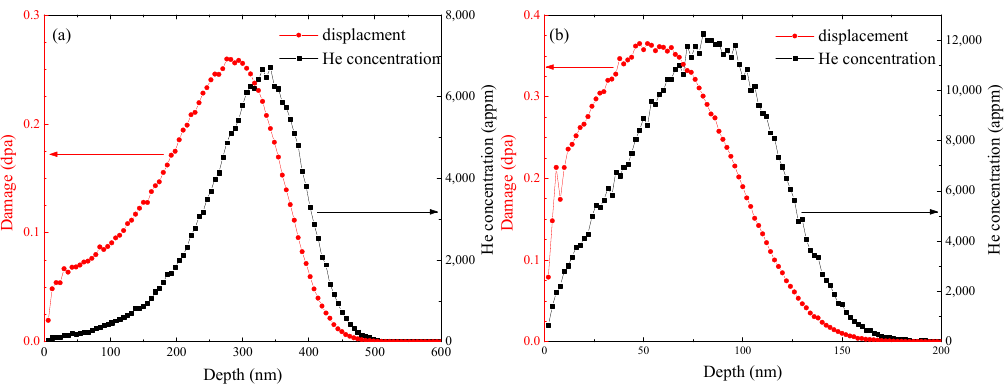
Figure 1. Depth profile of helium concentration and damage events in RAFM steels after irradiation to 1 × 10 20 m − 2 with ( a ) 100 keV ‐ He + and ( b ) 18 keV ‐ He + .